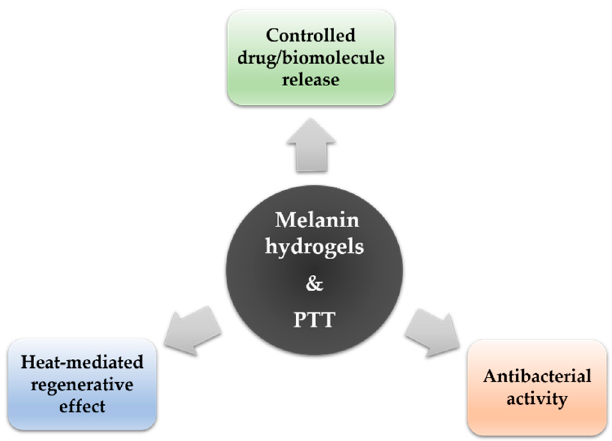
Figure 13. Photothermal-responsive melanin hydrogels: applications in wound healing.